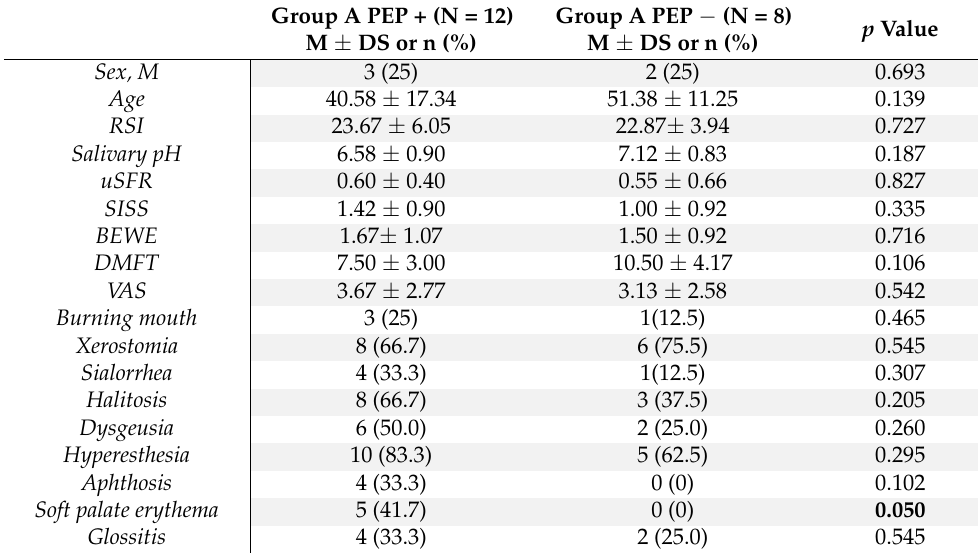
Table 3. Comparison between subgroup A PEP + and subgroup A PEP − .